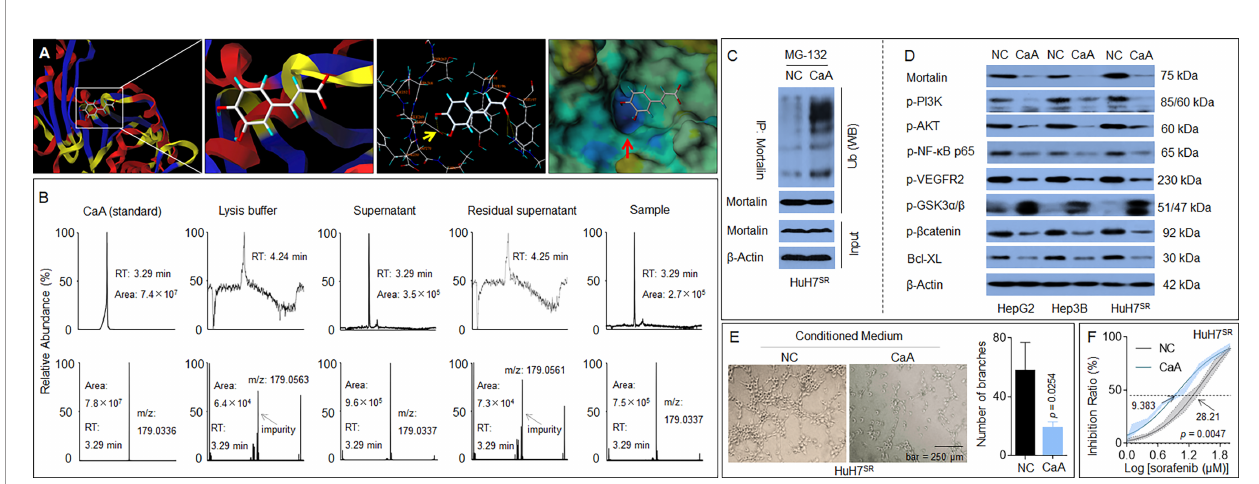
FIGURE 6 | Identi fi cation of a novel potential chemical inhibitor for mortalin: Caffeic acid (CaA). (A) SYBYL-X software was used to analyze the binding of CaA to mortalin. After HuH7 SR cells were pretreated with 20 m M MG-132 for 2 h, they were exposed to 20 m M CaA for 6 h. Mortalin was immunoprecipitated using a speci fi c antibody. (B) Liquid chromatography – mass spectrometry (LC-MS) quanti fi cation of the content of CaA in the mortalin-immunoprecipitation complex. (C) Western blotting analysis of the expression of ubiquitin in the mortalin-immunoprecipitation complex. (D) HepG2, Hep3B, and HuH7 SR cells were treated with 20 m M CaA for 24 h. Western blotting analysis of the expression of mortalin, phosphatidylinositol 3-kinase (PI3K)-p85 (Tyr458), Akt (Ser473), nuclear factor (NF)- k B (Ser536), vascular endothelial growth factor receptor (VEGFR)2 (Tyr951), glycogen synthase kinase (GSK)3 b (Tyr216), b -catenin (Thr41/Ser 45), and Bcl-XL. (E) Capillary tube formation assay of the effects of CaA on tube formation in human umbilical vein endothelial cells (HUVECs); a quantitative analysis, determined in triplicate, is provided. (F) HuH7 SR cells were treated with 20 m M CaA and then treated with different concentrations of sorafenib for 24 h. The cell viability was determined in triplicate, and the IC50 values were calculated. The differences were analyzed using Student ’ s t -test and two-way analysis of variance followed by Sidak ’ s multiple comparison